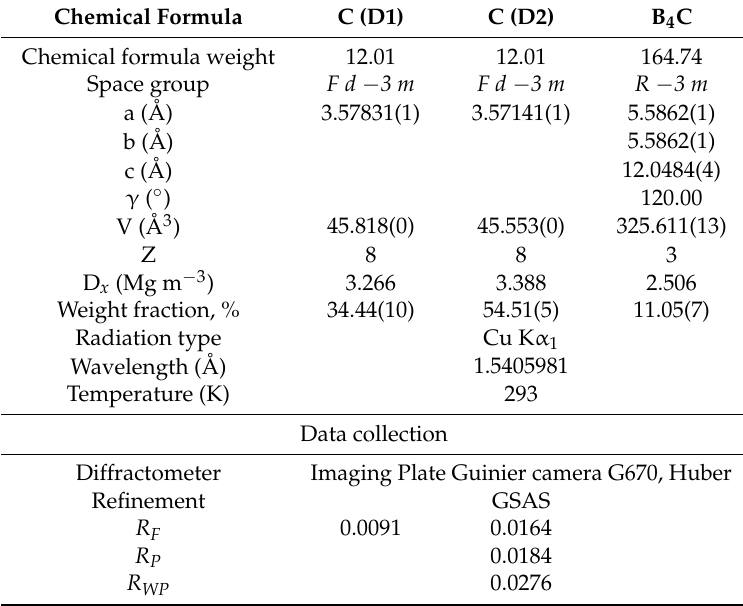
Table 1. Experimental details for D1, D2, and B 4 C (sample N1).